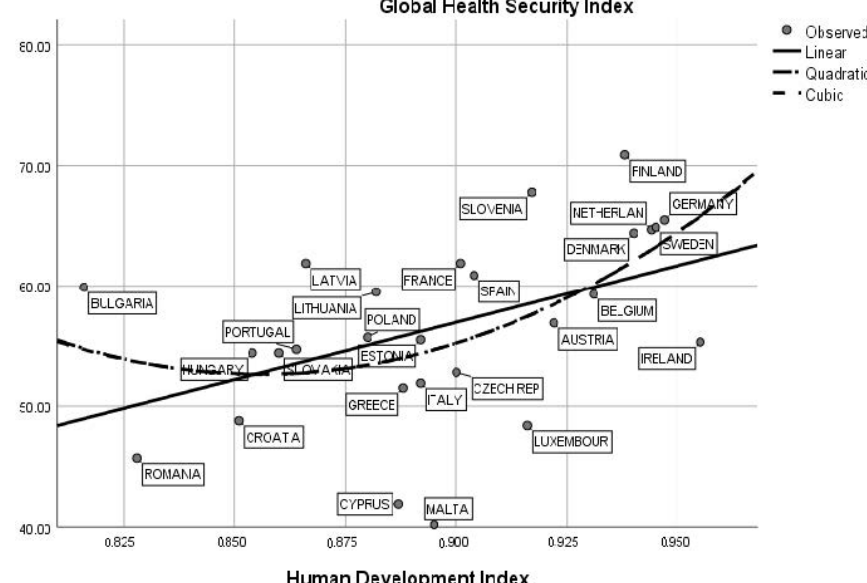
Figure 4. Correlation between Human Development Index and Global Health Security Index. Au- thor’s quantitative determination based on statistical data presented in Section 2 (Research Methods).